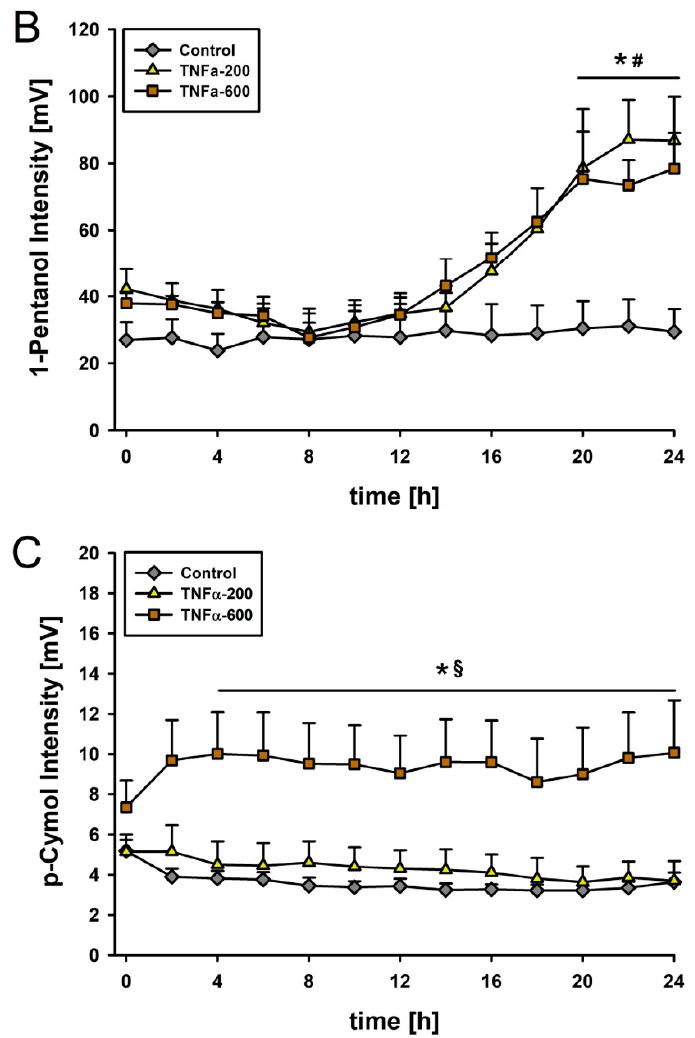
Figure 2. ( a ) 1-butanol during observation period. * p < 0.05 for TNF- α -200 and TNF- α -600 vs. control group; ( b ) 1-pentanol: *# significant increase of 1-pentanol intensity for both TNF- α groups vs. baseline and vs. control group; ( c ) Course of p-cymol intensity: * p < 0.05 TNF- α -600 vs. control group. § p < 0.05 TNF- α -600 vs. TNF- α -200. Data presented as means ± SEMs. N = 10 per group at the beginning of the experiment.